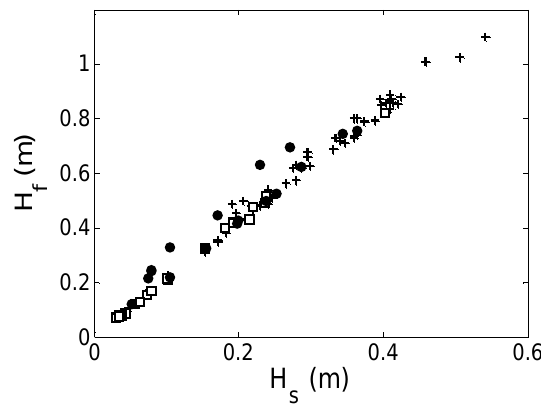
Figure 4. Scatter diagram of freak wave height and significant wave height for positive height for positive (crosses), negative (circles) and sign-variable (crosses), negative (circles) and sign-variable (squares) freak waves. (squares) freak